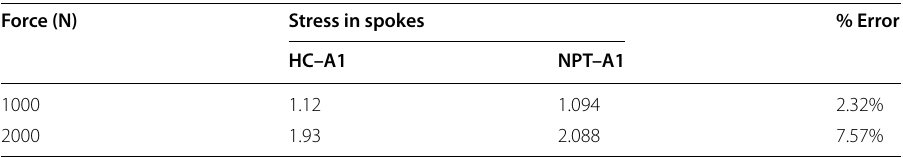
Table 5 Comparison of stress in spokes of HC–A1 and NPT–A1, NPTs [12] Force (N) Stress in